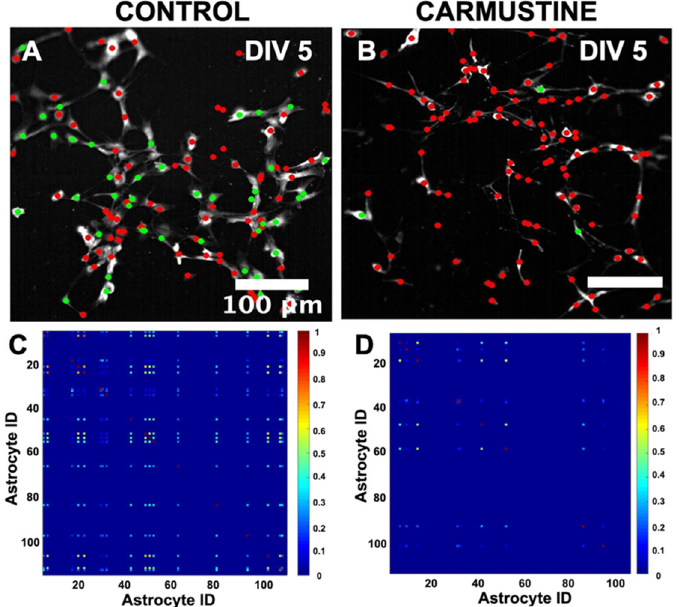
Figure 7. Global network synchronization in cerebellar astrocytes in culture. ( A , B ). Representative images of a pairwise synchronization matrix that show the coactive astrocytes exhibiting transient calcium events between all active astrocyte pairs. ( C , D ). Representative images of core ensemble, defined as a group of coactive astrocytes. Each astrocyte (colored circle) is a node. The nodes that are conserved in all significantly correlated ensembles are in green and the rest are in red. The core ensemble preserves the spatial distribution of the astrocytes in the culture. The calibration bar corresponds to the events in which astrocytes activated together. (87.25 ± 15.36 astrocytes were recruited at DIV5 culture, Control n = 4, 8 pups were used, 2 for each control culture, whereas 89.50 ± 12.29 astrocytes were recruited at DIV 5, Carmustine n = 4, 8 pups, 2 for each carmustine culture).